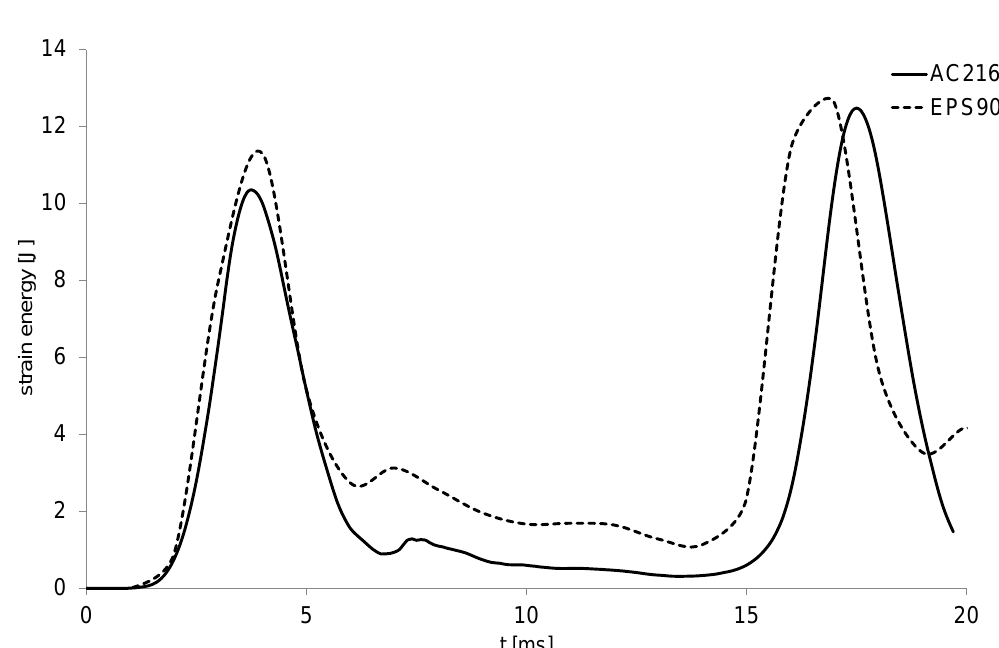
Figure 12. CSF strain energy history during the double impacts with both 40 mm thick AC and EPS solutions.